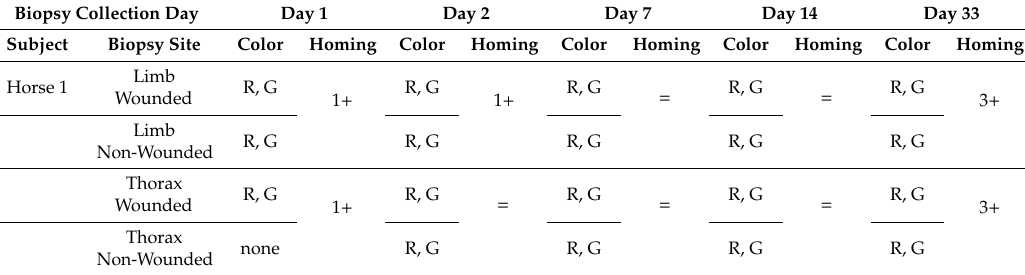
Figure 3. Representative confocal microscopy images of normal skin of the limb and thorax before surgical creation of wounds. (a ) Horse 2, thorax, ( b ) horse 2, thorax, ( c ) horse 1, thorax, and ( d ) horse 1, limb. Images were selected from either horse 1 or horse 2 and from either the limb or thorax as was determined to be the best representative image of normal skin. In both the limb and thorax, collagen fibers demonstrated normal green and red auto-fluorescence. No cell-like structures resembling cultured prepared CB-MSCs were detected. Table 1. Summary of labeled CB-MSC fluorescent signal color and homing to